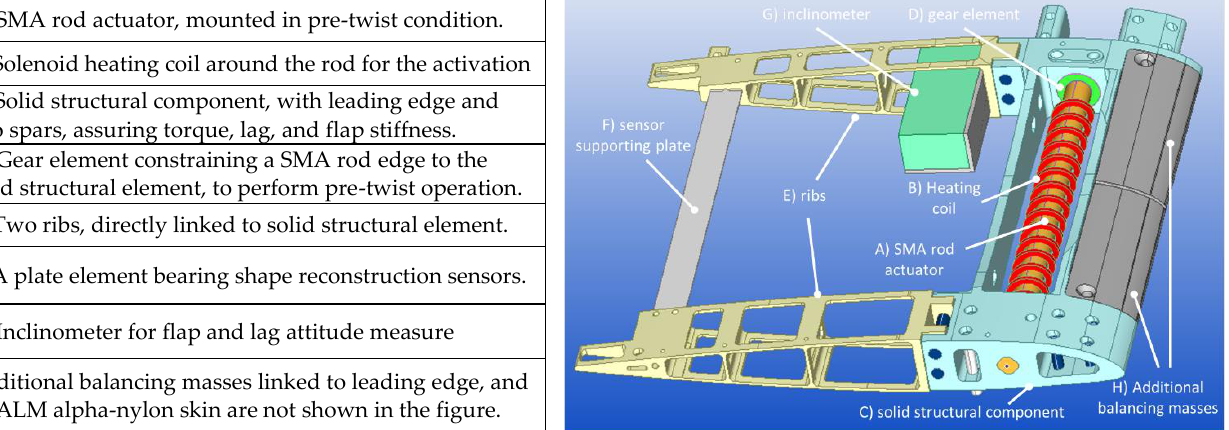
9 of 27 Figure 8. The full-scale demonstrator of the adaptive winglet (mounted on the test rig (Reprinted/ adapted with permission from Ref. [38] Copyright © 2022). 2.3. Shape Adaptive Blade Description The SMA blade twist concept was developed within the Project “ Shape Adaptive Blades for Rotorcraft Efficiency ” (SABRE) [29], under the H2020 framework. CIRA devel- oped a morphing system that was able to change the blade twist in compliance with the targets of the Project: the elaboration of adaptive technologies affecting the main rotor features to improve the helicopter performance. The core of the architecture consists of a